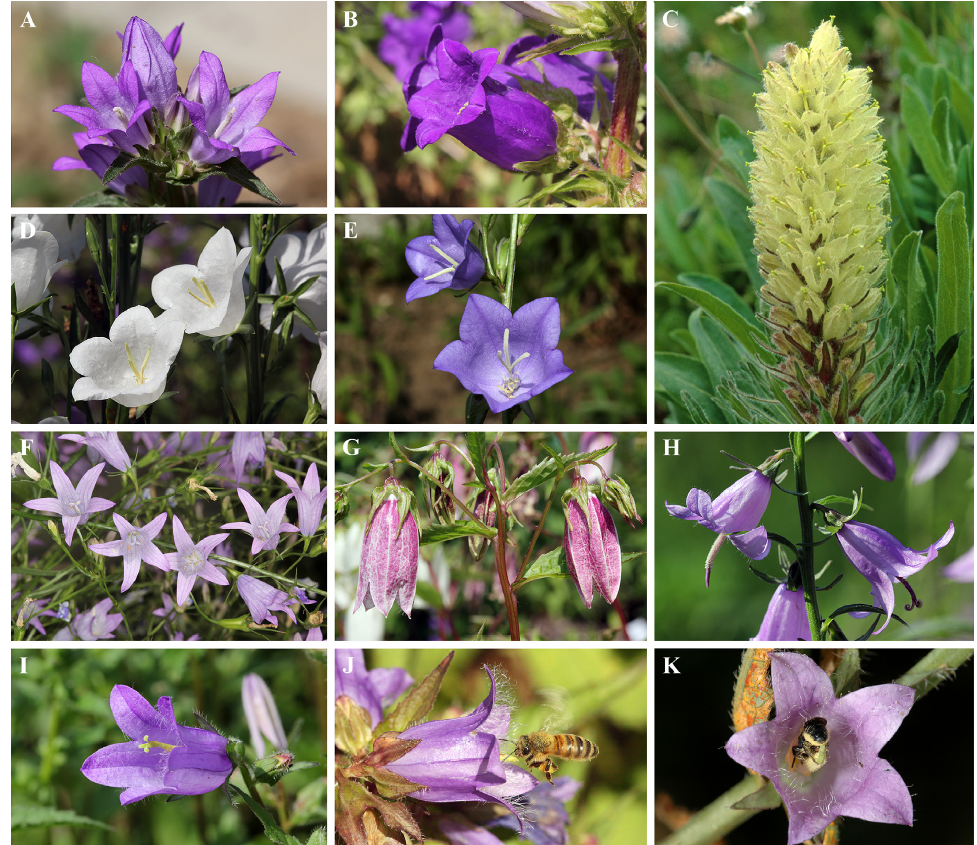
Figure 5. Flowers and flower visitors of some of the Campanula species investigated in this study. ( A ) C. glomerata , ( B ) C. medium , ( C ) C. thyrsoides , ( D ) C. persicifolia subsp. alba , ( E ) C. persicifolia , ( F ) C. rapunculus , ( G ) C. punctata , ( H ) C. rapunculoides, and ( I ) C. trachelium , ( J ) a honey bee